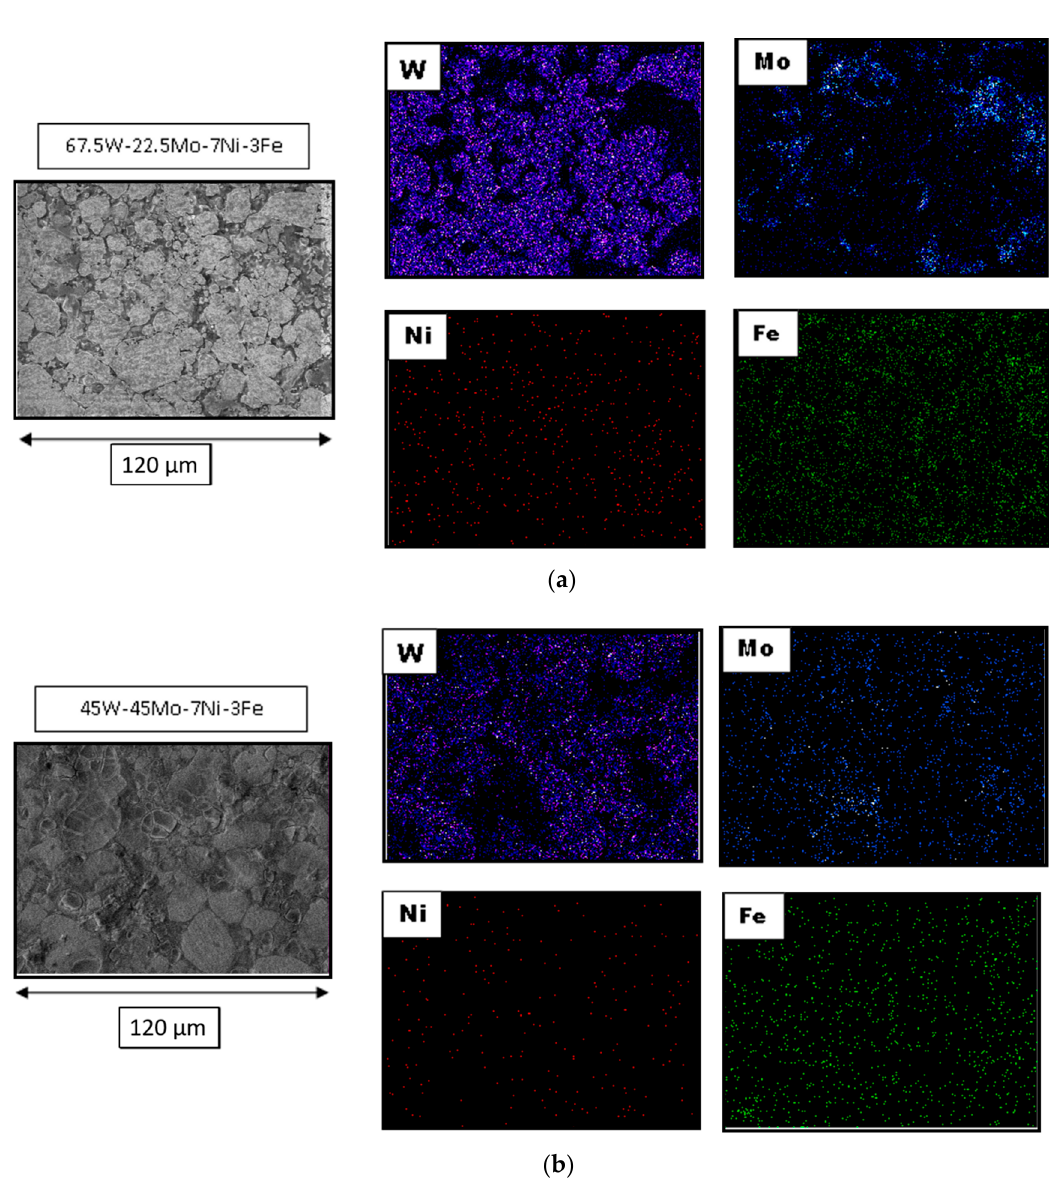
Figure 5. ( a ) Elemental mapping of 67.5W-22.5Mo-7Ni-3Fe, ( b ) elemental mapping of 45W-45Mo-7Ni-3Fe. Table 3. Relative sintered density, grain size, and contiguity of all sintered heavy alloys. S. No.